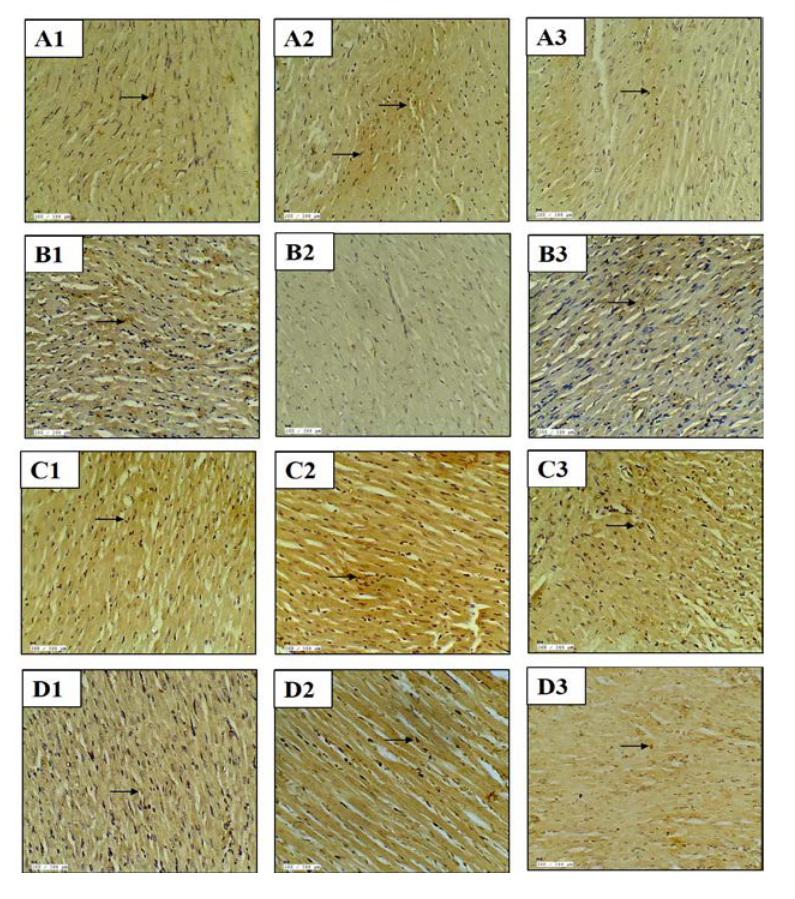
Figure 2. Effect of kaempferol on ( A1 – A3 ) Bax immunohistochemistry; ( B1 – B3 ) Bcl-2 Figure immunohistochemistry; ( C1 – C3 ) Caspase-3 immunohistochemistry; ( D1 – D3 ) TUNEL assay. ( A1 – D1 ) diabetic control; ( A2 – D2 ) diabetes + ischemia-reperfusion and ( A3 – D3 ) diabetes + kaempferol 20 mg/kg + ischemia-reperfusion; n = 3 in each group; 20×; scale bar 100 μm; ( → ): positive stain.